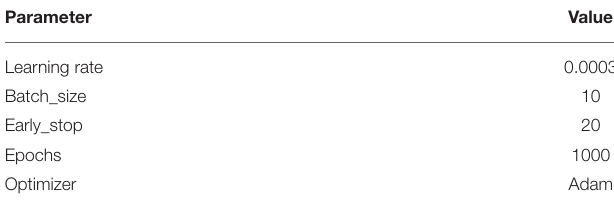
TABLE 2 | Training parameters